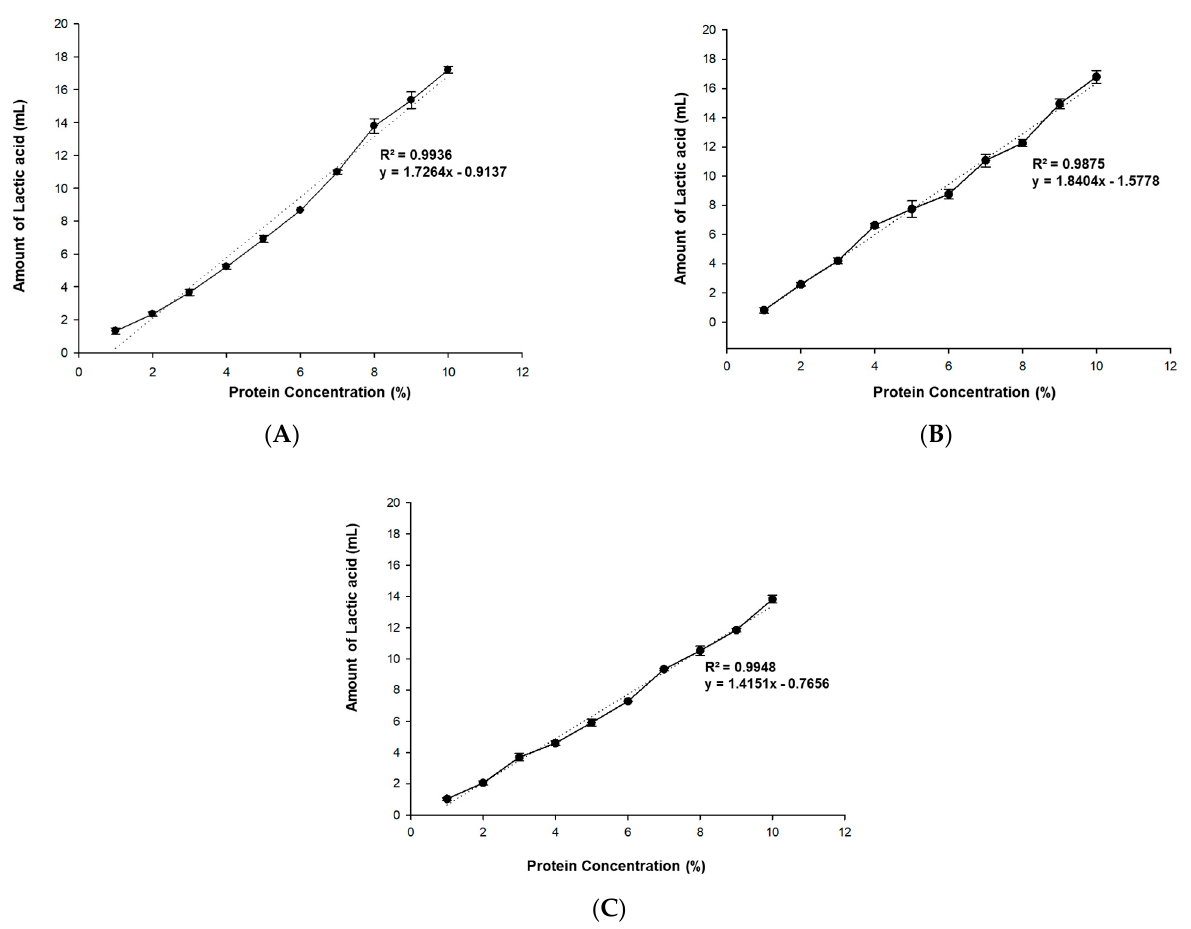
Figure 1. Titration capabilities of plant proteins: ( A ) isolated soy protein (ISP), ( B ) pea protein (PP), and ( C ) almond protein (AP).